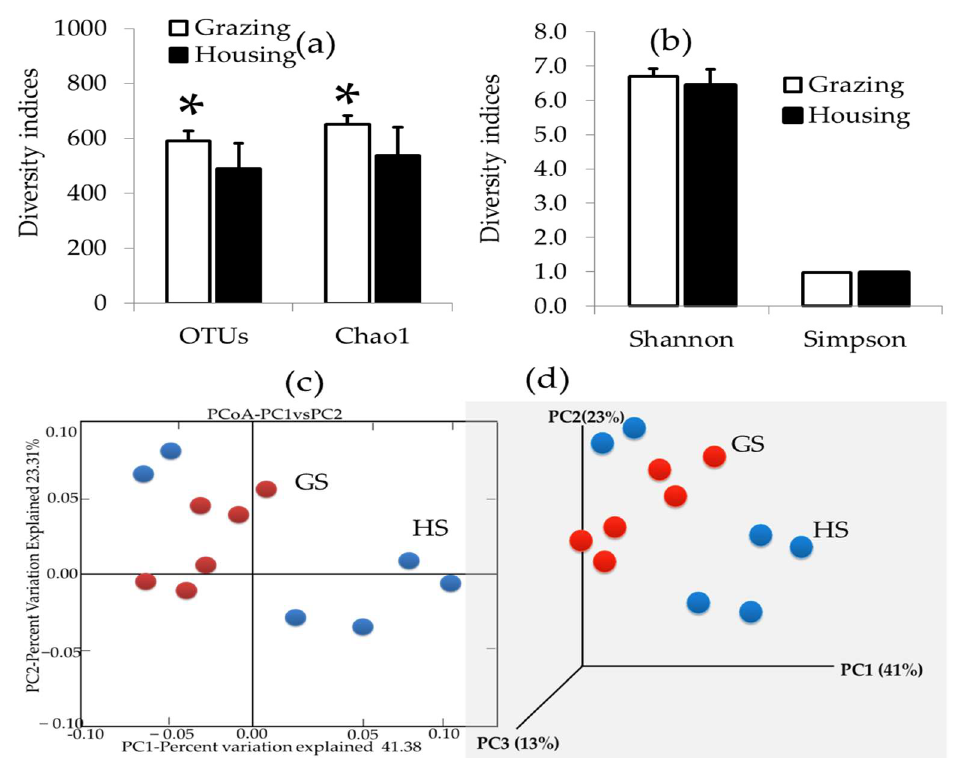
Figure 1. Diversity indices and principal coordinate plots, operational taxonomic units (OTUs), and level-weighted UniFrac distance between steer groups. ( a ) OTUs and Cho1 indices of bacterial diversity; ( b ) Shannon and Simpson indices of bacterial diversity; ( c ) 2D PCA of steer groups; ( d ) 3D PCA of steer groups. GS: grazing steer; HS: housing steer. * p < 0.05; grazing steer (GS) vs. housing steer (HS).